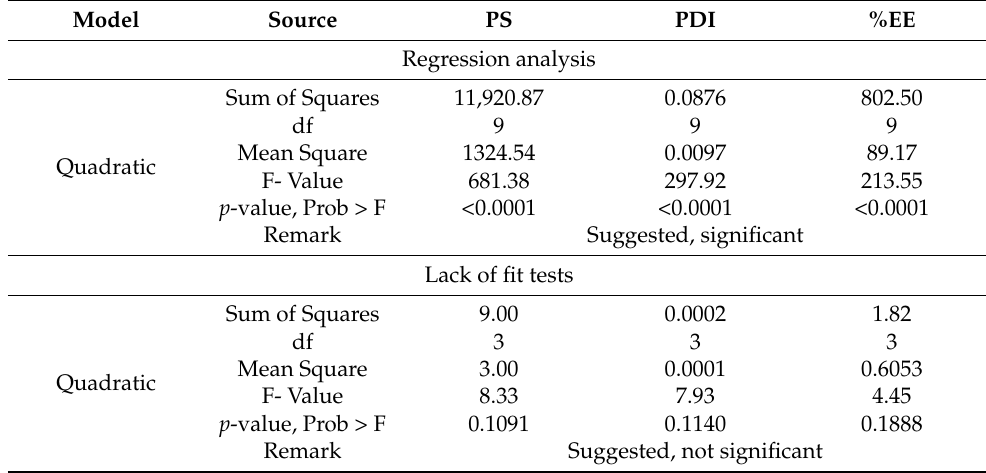
Table 4. ANOVA data obtained after regression analysis and lack-of-fit tests for the best-fitting quadratic model for R 1 (PS), R 2 (PDI), and R 3